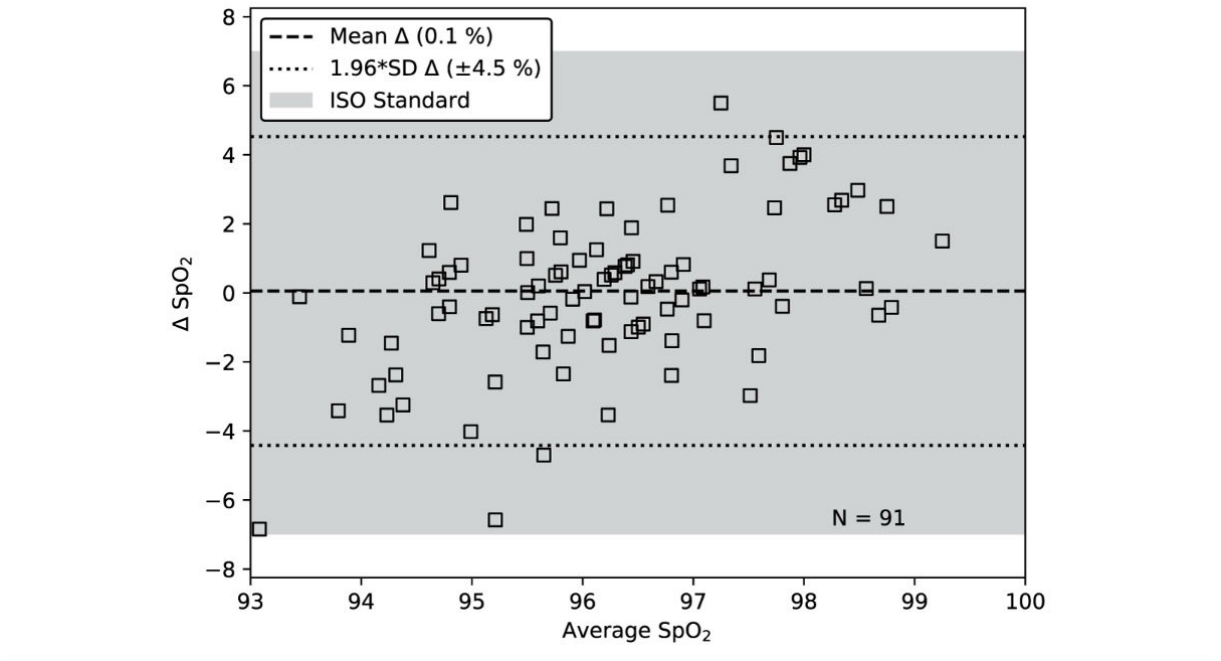
Figure 8. The limits of agreement for SpO 2 (peripheral oxygen saturation) is 4.5% with an A RMS (root mean square error) of 2.3%. This exceeds the accuracy required by the ISO standard for SpO 2 where A RMS, MAX is 3.5%, which equates to a limits of agreement of 6.9% (shaded